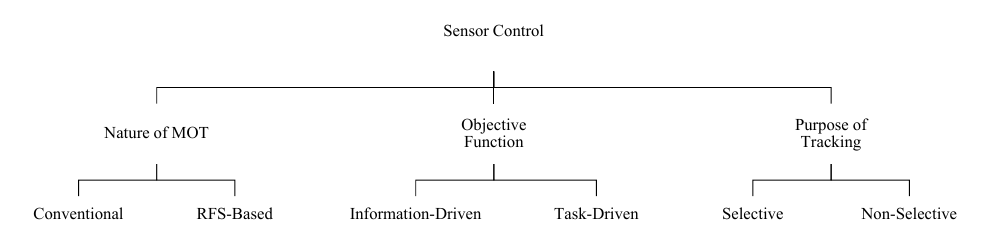
Figure 3. Classification of recent advanced sensor control solutions for multi-object tracking